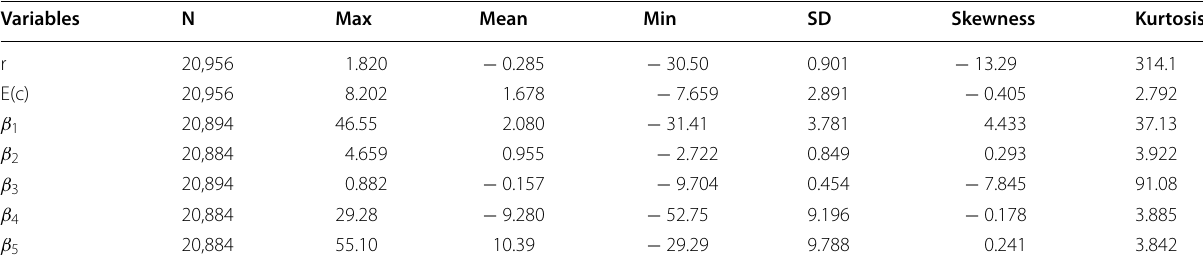
This table provides the descriptive statistics of monthly stock returns, expected illiquidity costs, market stock beta, three liquidity risks, and aggregate liquidity risks. N, max, min, sd represent the number of observations, maximum, and standard deviation, respectively. r i monthly stock returns, E(c) expected illiquidity costs, β 1 market stock beta, β 2 , β 3 , β 4 liquidity risk, β 5 aggregate liquidity risk